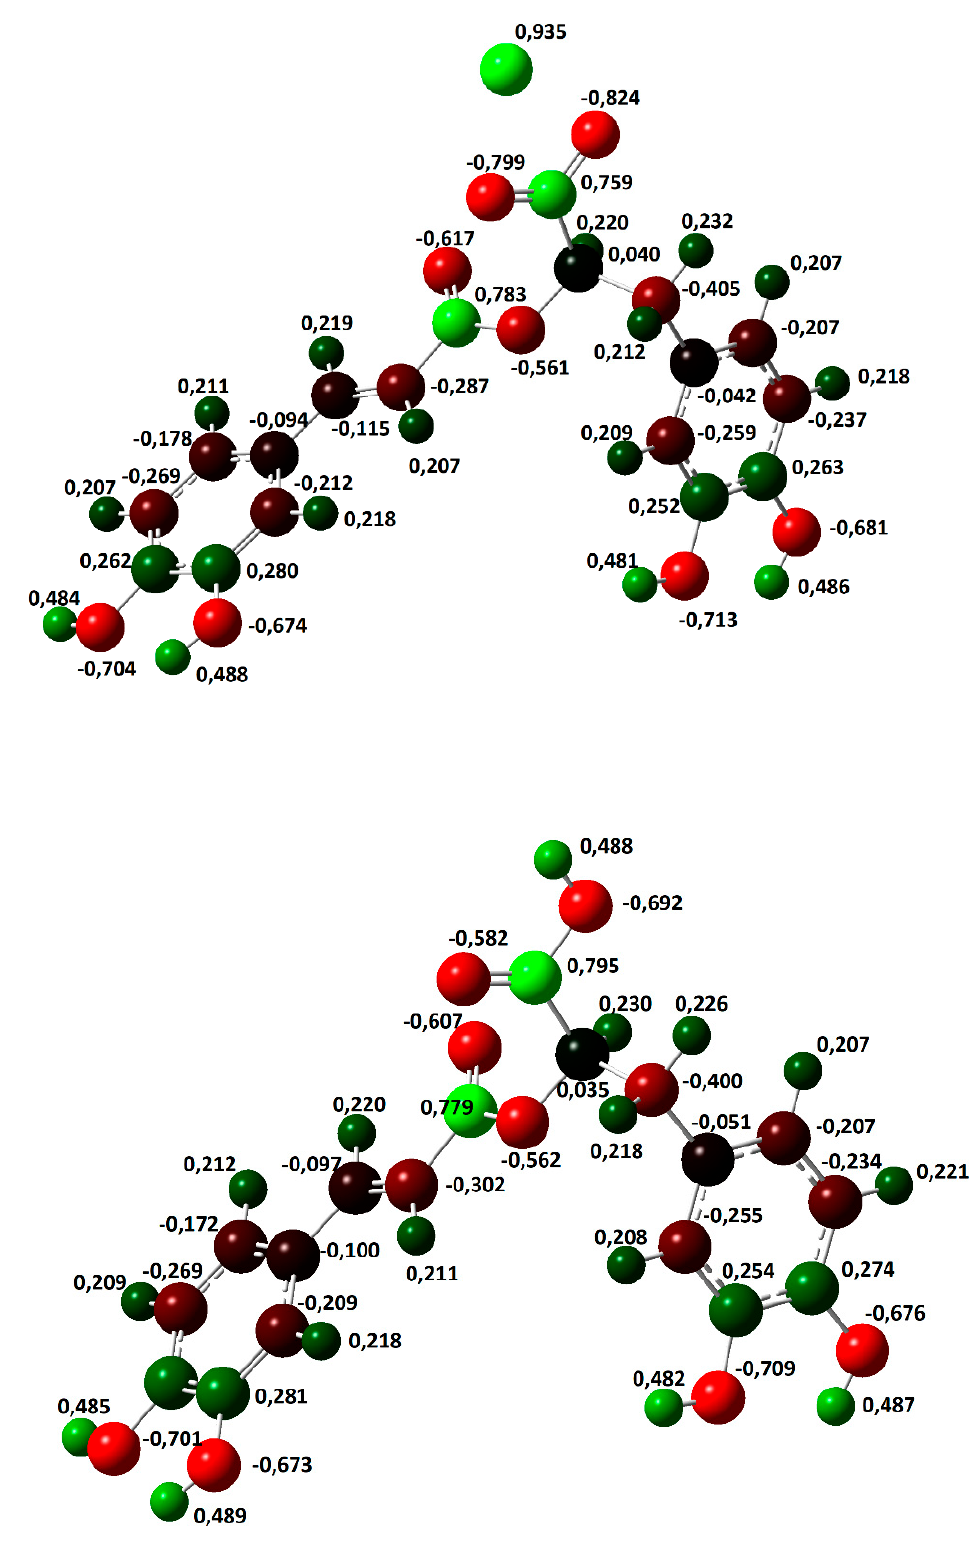
Figure 2. Optimized molecular structures of rosmarinic acid ( B ) and its sodium salt ( A ) as well as atomic charges.